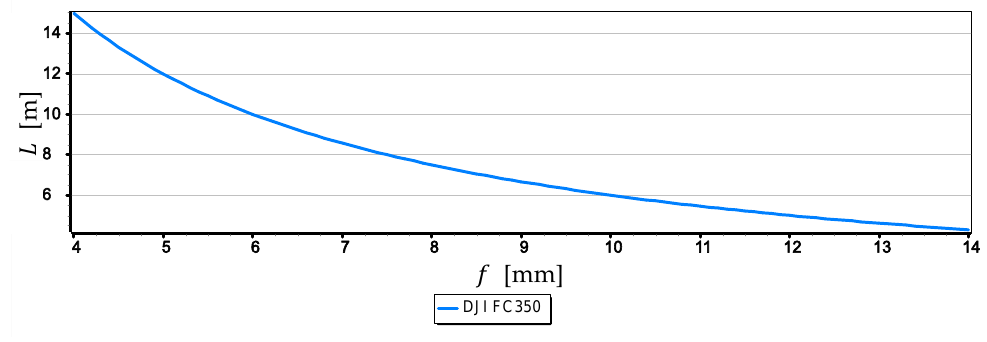
Figure 9. Single-pixel measurement resolution L of the horizon line as a function of focal length f from 4 mm to 14 mm for camera DJI FC5350 ( h = 100 m).